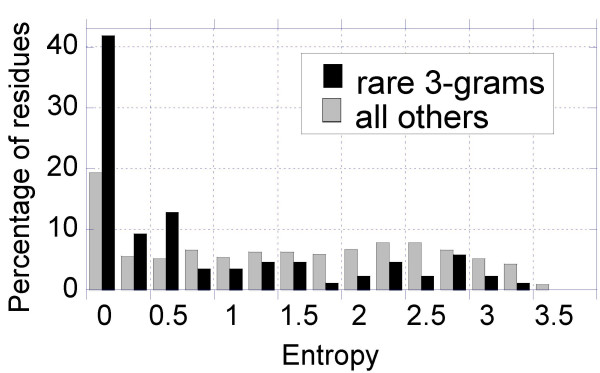
Histogram of Shannon entropies. for amino acids participating in rare 3-grams (black) and other amino acids (dashed), based on the family memberships in the examined three cases (Src, Hb and Tyr tRNA synthetase). The abscissa shows the percentages of amino acids corresponding to bins of size Δ S = 0.25. We note the high propensity of rare residues in the range S < 0.25 corresponding to highest conservation.